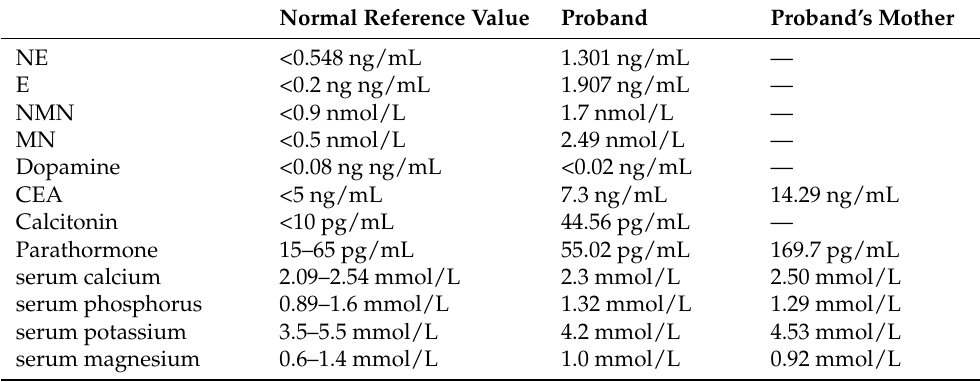
Table 1. Laboratory examinations compared between the proband and his mother before